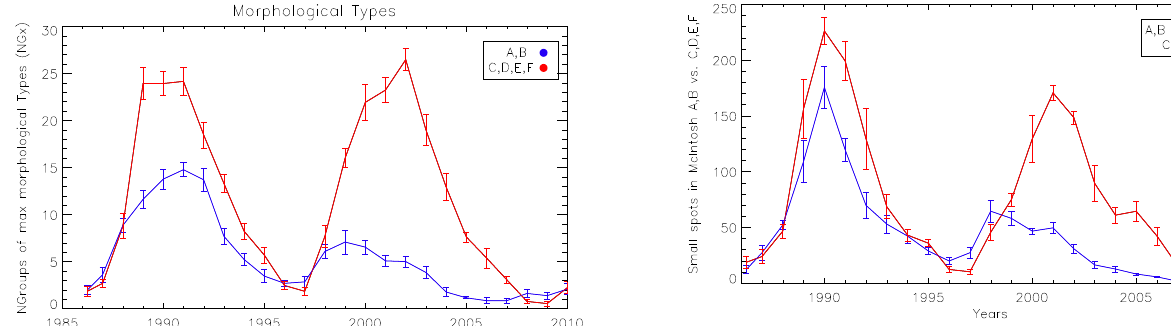
Fig. 7. Evolution of the number of small spots without penumbra (area < 17 l sh and ratio (total area)/(umbral area) < 7) belonging to small A and B-type groups (black curve) and to large C, D, E and F-type groups (red curve) over cycles 22 and 23. Although it is less marked in large groups (ratio 1.3 ± 0.2 compared to 3.2 ± 0.5 in small groups), a deficit is observed during cycle 23 in all types